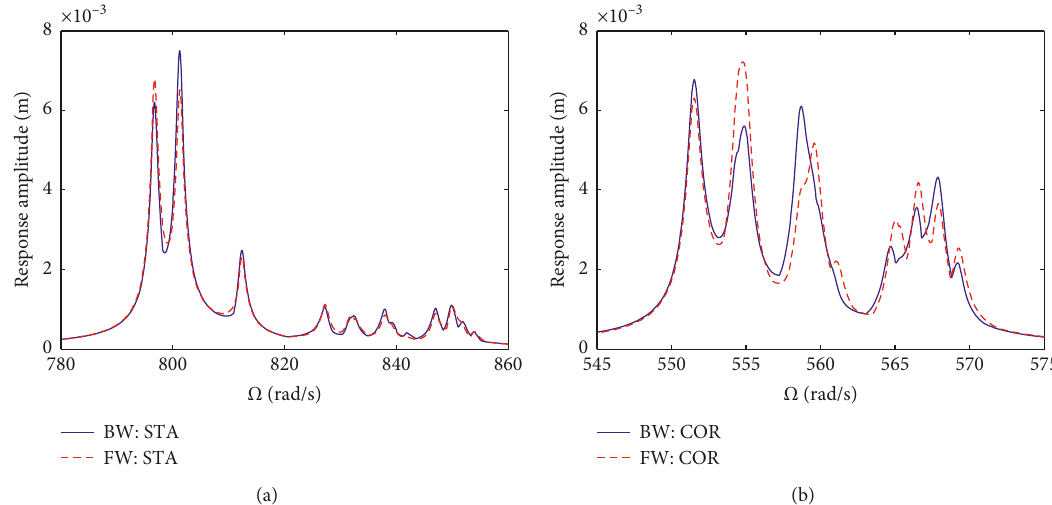
Figure 9: Forced response of mistuned bladed disk excited by backward and forward traveling wave excitations of (a) 2EO and (b) 3EO.